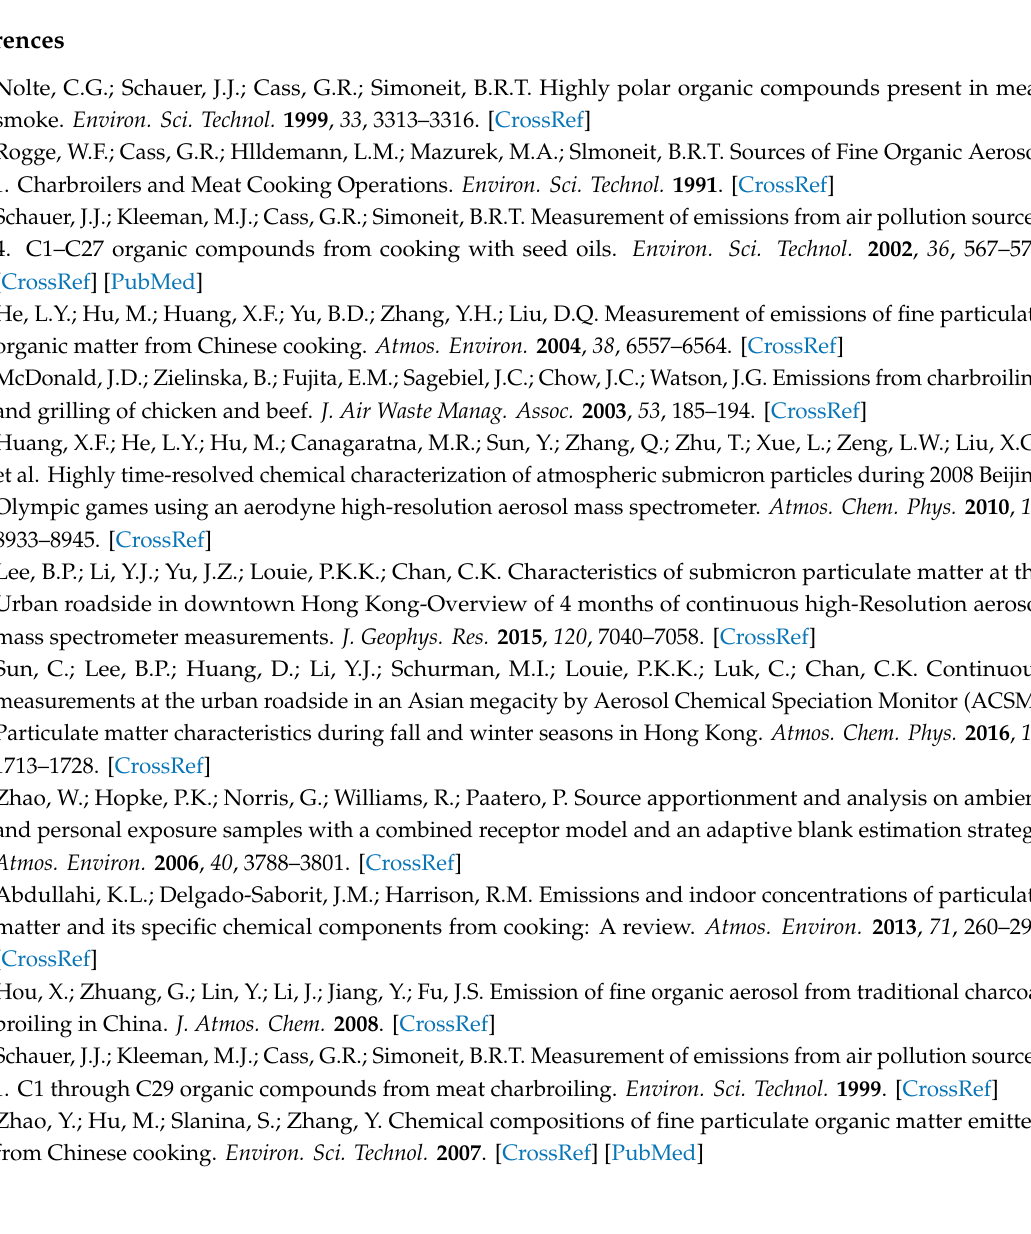
profile, Figure S4. Comparison of source profiles resolved by base runs of PMF CholC16C18 and PMF Chol , Figure S5. Comparison of source profiles resolved by base runs of PMF CholC16C18 and PMF C16C18 , Figure S6. Scatter plots with correlation coe ffi cients and linear regressions of modelled against observed data for PM 2.5 , OC, palmitic acid, stearic acid and cholesterol, Figure S7. Factor source contributions to OC (%) from PMF CholC16C18 for individual samples. Figure S8. Scatter plots of modelled data from PMF CholC16C18 and PMF wo against observed OC data. Figure S9. Scatter plots of modeled against observed OC data from PMF CholC16C18 and PMF wo . PMF CholC16C18 refers to the PMF run with all cooking tracers (cholesterol, palmitic acid and stearic acid) included. PMF wo refers to the PMF run without cooking tracers included. The solid line represents the regression equations generated by orthogonal distance regression and the dashed line is one-to-one